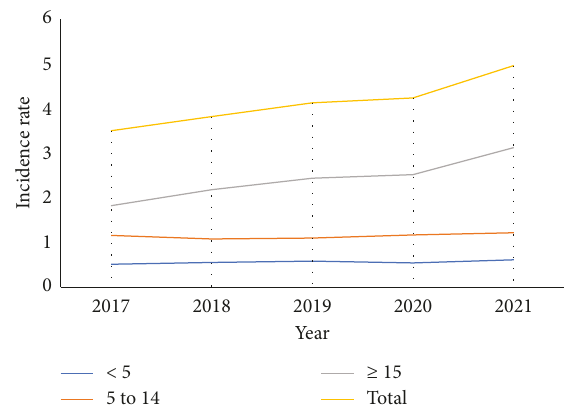
Figure 5: Incidence rate per total population at risk by age group in Decha and Gimbo districts, Southwest Ethiopia (2017-2021).